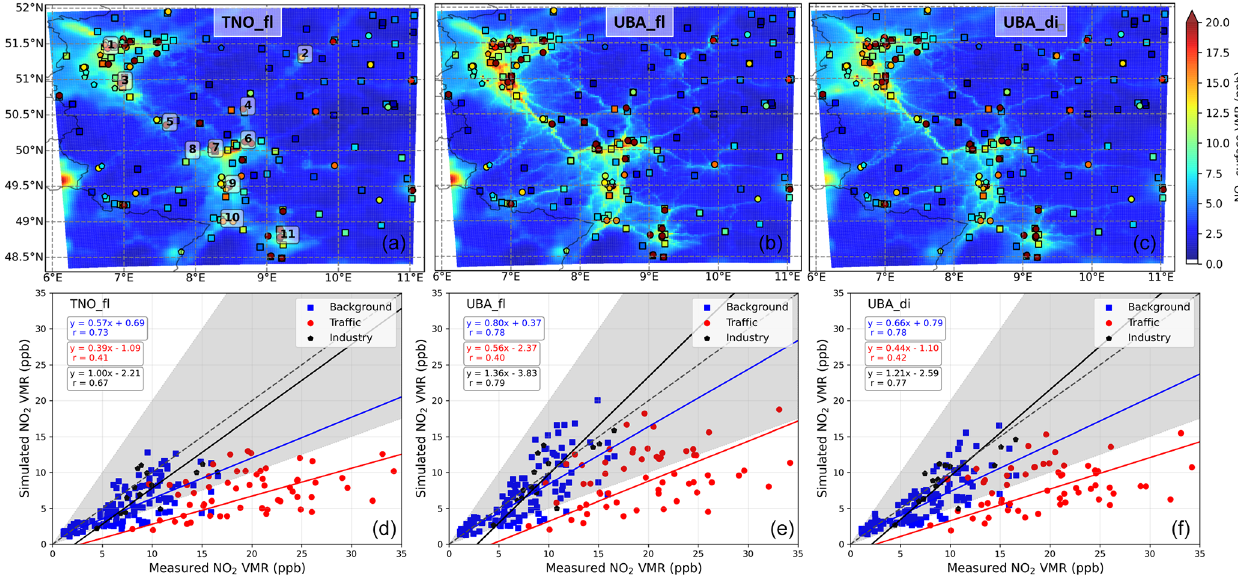
Figure 4. (a, b, c) Spatial distribution of monthly-mean NO 2 surface VMRs for the three simulations using different emission inventories ( a, d : TNO, b, e : UBA without diurnal variations, c, f : UBA with diurnal variations) for CM02 for May 2018. The square, circle and pentagon markers overlaid on the maps represent the monthly-mean measured NO 2 VMRs for background, traffic and industrial locations, respectively. The numbers on the top left panel correspond to the following German cities in decreasing order of latitude coordinate values, i.e. 1: Duisburg, 2: Kassel, 3: Köln, 4: Gießen, 5: Koblenz, 6: Frankfurt, 7: Mainz, 8: Bingen, 9: Mannheim, 10: Karlsruhe 11: Stuttgart. (d, e, f) Scatter plot and orthogonal distance regression weighted by the inverse of the square of the standard deviation of simulated monthly- mean NO 2 surface VMRs with respect to the in situ measured values for different station types (background: blue square; traffic: red circle, and industrial: black